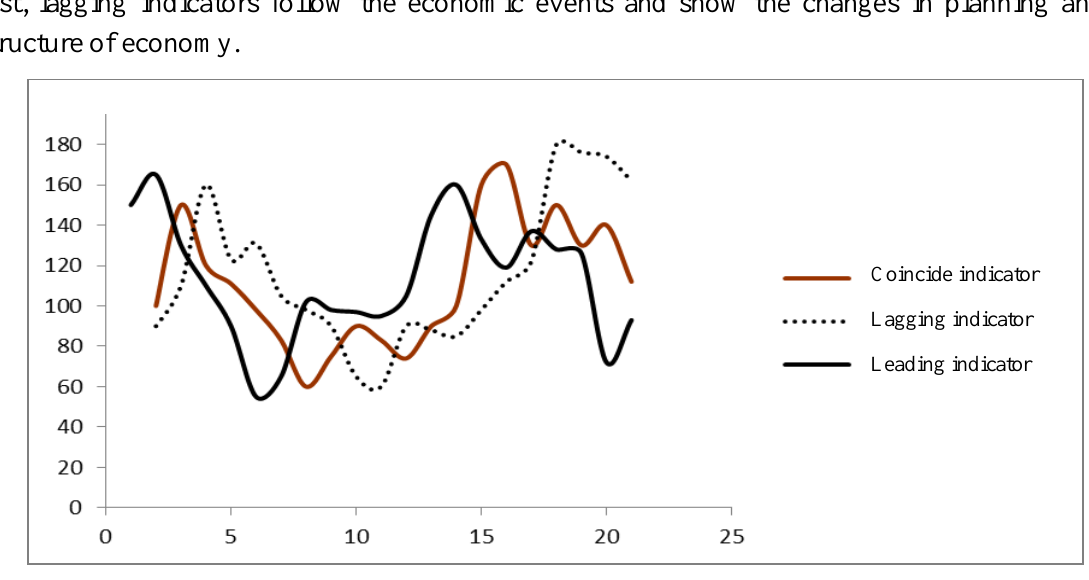
Figure1. A schematic presentation of composite